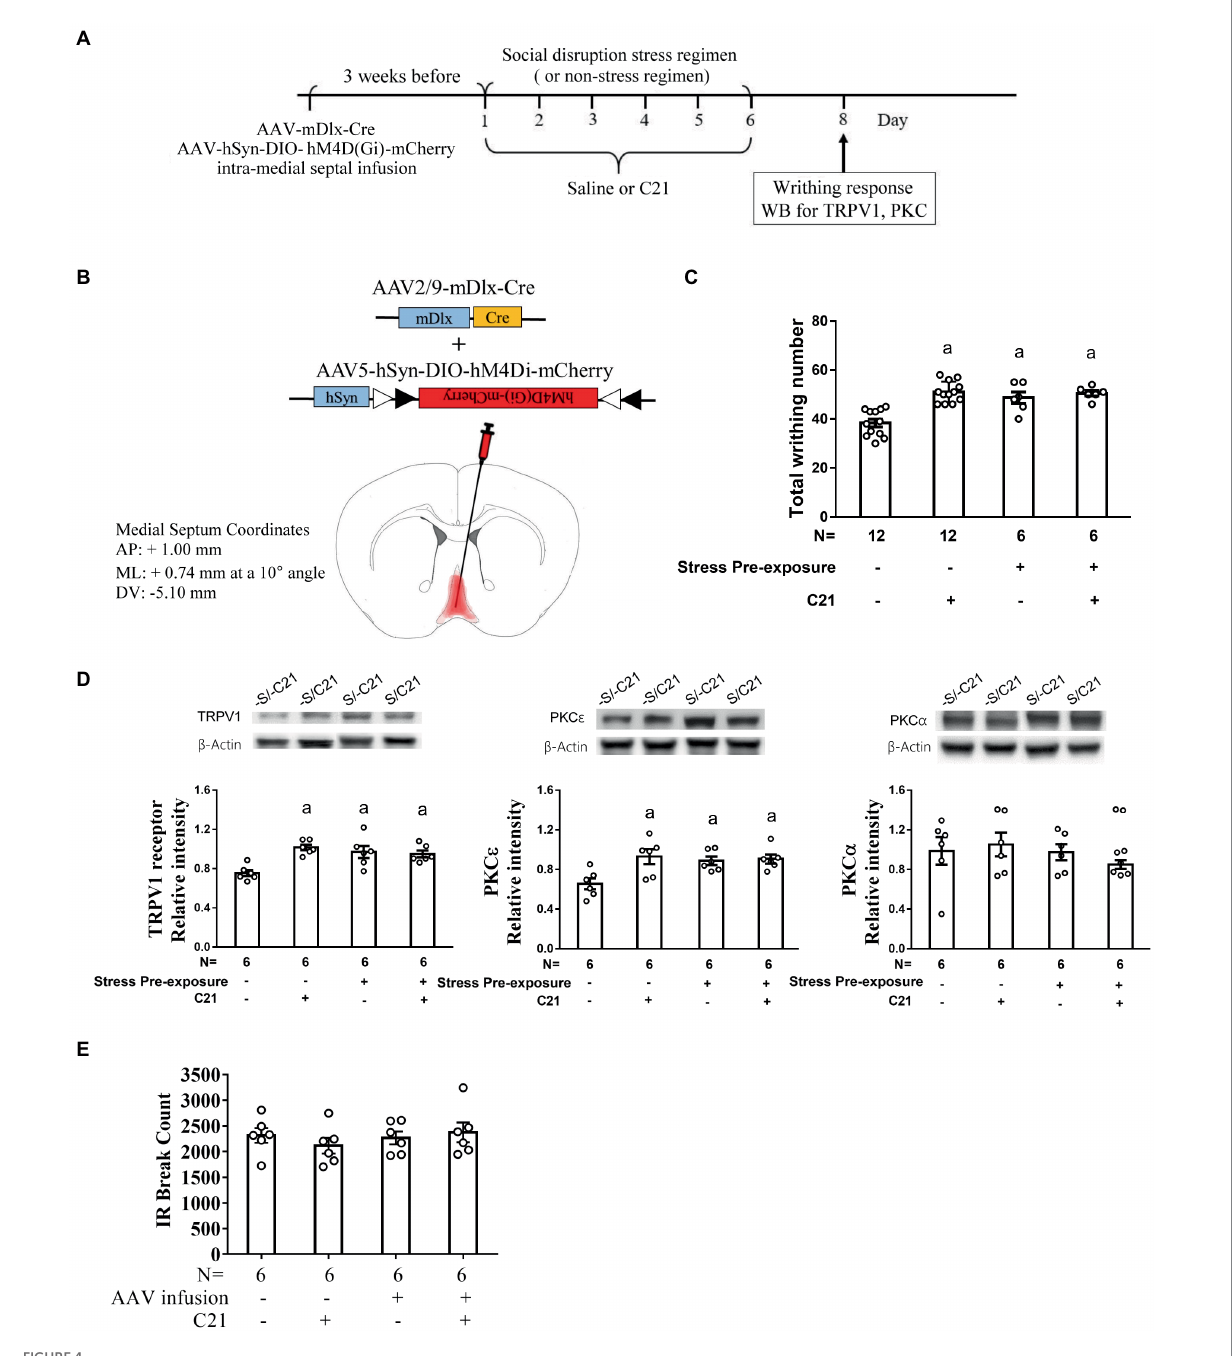
(Supplementary Figure S3A). Three weeks after viral infusions, 62.1 ± 4.4% of dorsal LS cholinergic neurons were also mCherry- positive, suggesting acceptable infection efficiency by employing this retrograde AAV intersection strategy. Moreover, approximate 82.3 ± 2.8% mCherry-positive cells were cholinergic neurons using such methods, suggesting low off-target effect of intra-dorsal LS and